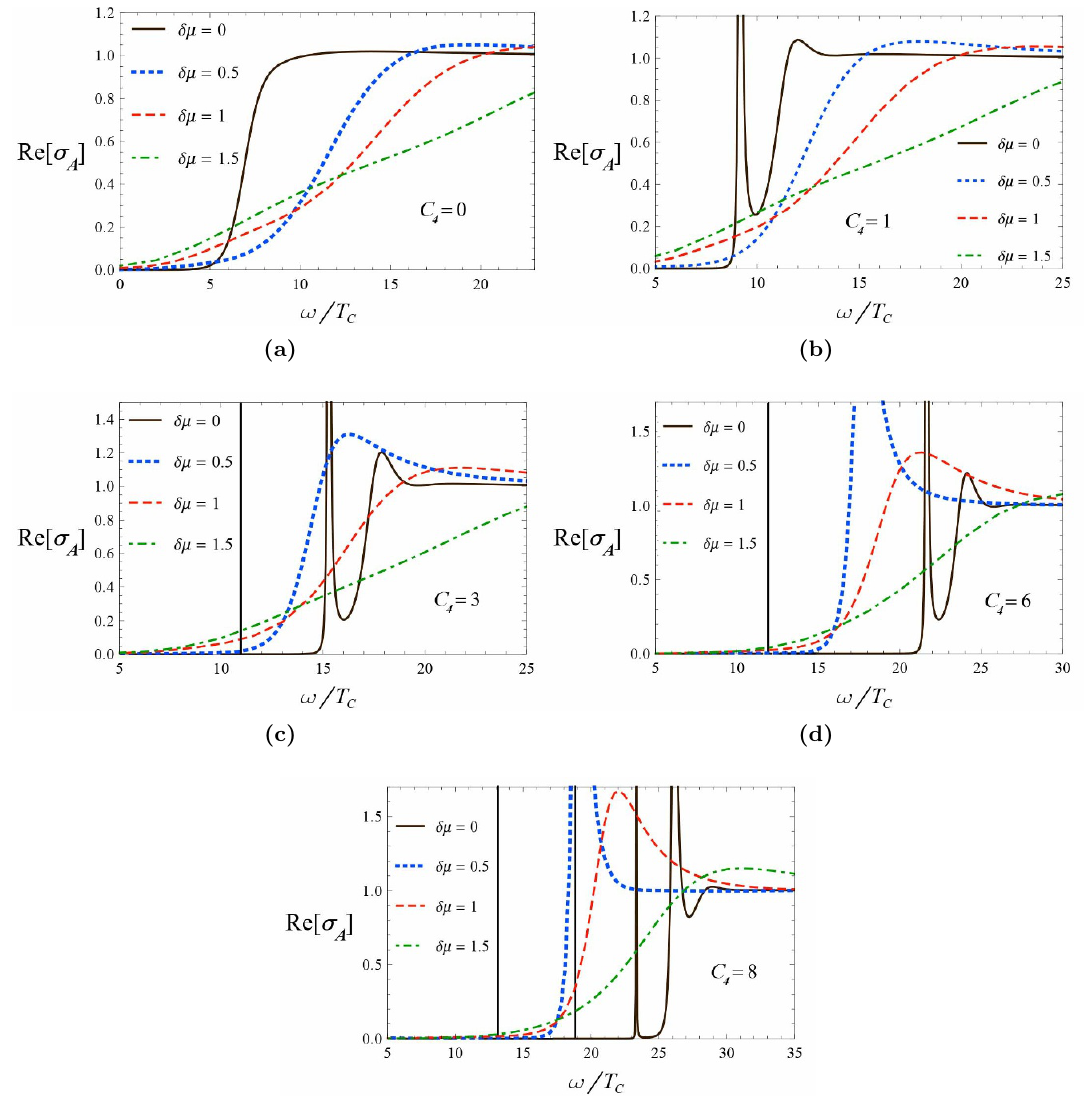
Figure 7. The optical electric conductivity in terms of !=T c for function F ( ) = 2 + C 4 4 and (cid:14)(cid:22) = 0 ; 0 : 5 ; 1 ; 1 : 5 (solid curve, dotted curve, dashed curve, and dot-dashed curve). In each (cid:12)gure we have (cid:12)xed values C 4 = 0 ; 1 ; 2 ; 3 ; 6 ; 8 for (cid:12)gures (a), (b), (c), (d), and (e),